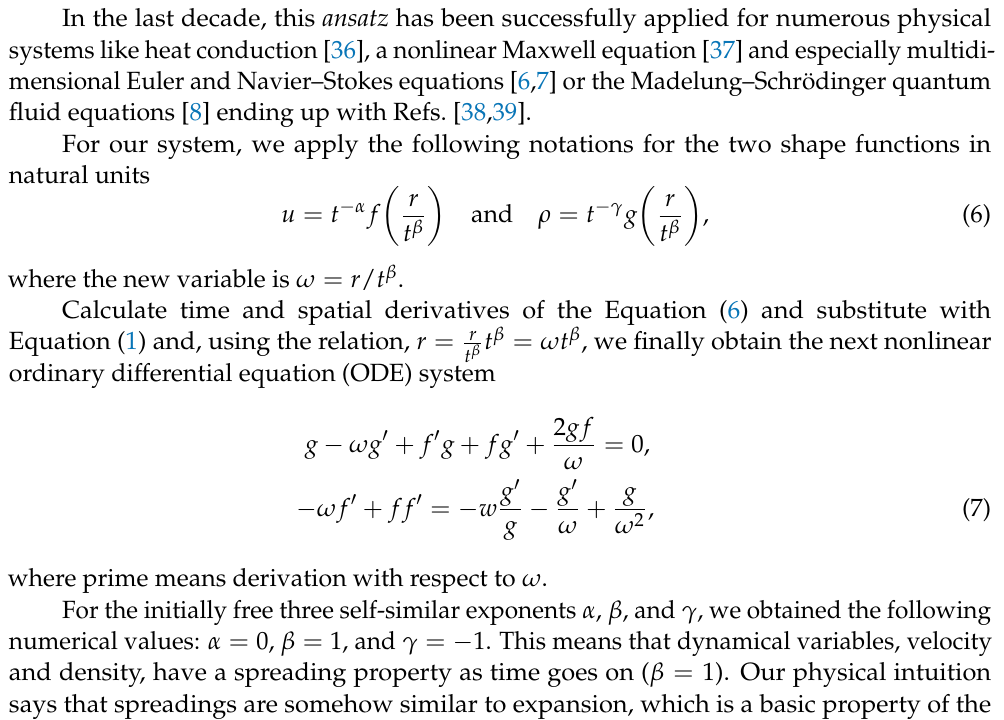
Figure 2. A self-similar solution of Equation (5) for t 1 < t 2 . The presented curves are Gaussians for regular heat